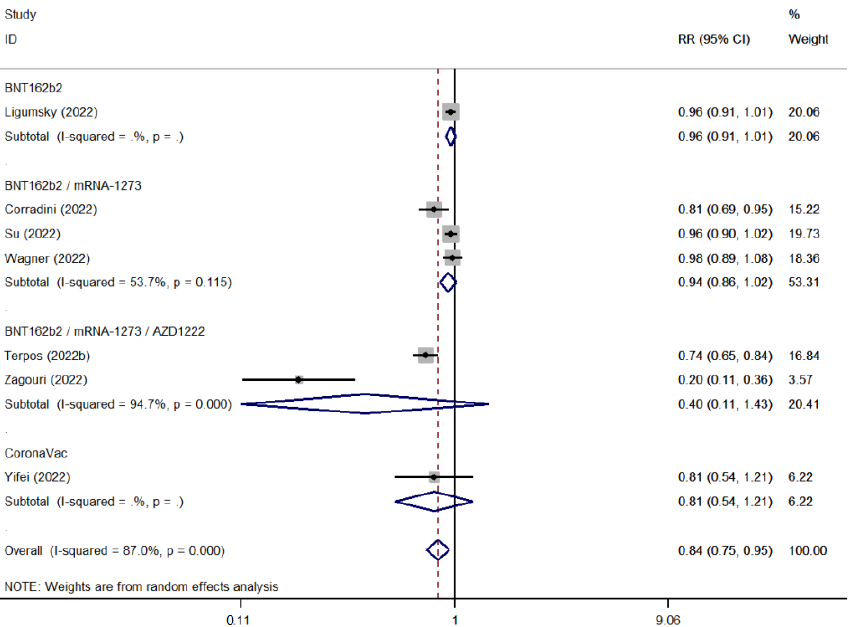
Figure 9. Pooled RelativeRisk (RR) for the immune seroconversion of patients with solid tumors after the third dose of COVID-19 vaccine [79,99,106,109,127,129,135].